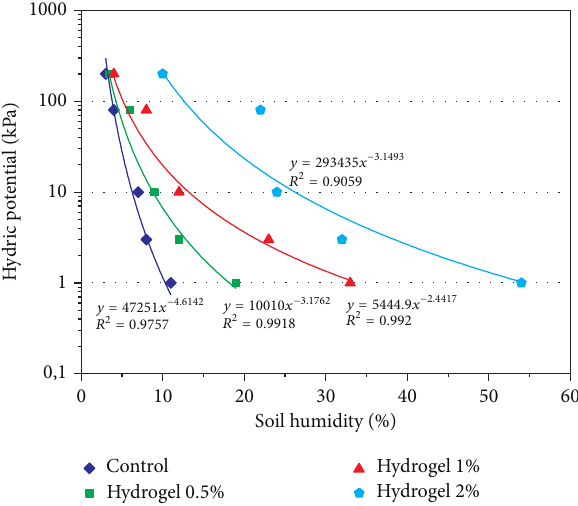
Figure 7: Water content in the soil as a function of the number of days after watering: effect of different hydrogel contents. Figure 8: Effect of hydrogel concentration on soil suction potential: both saturated and residual water content increase as hydrogel concentration is